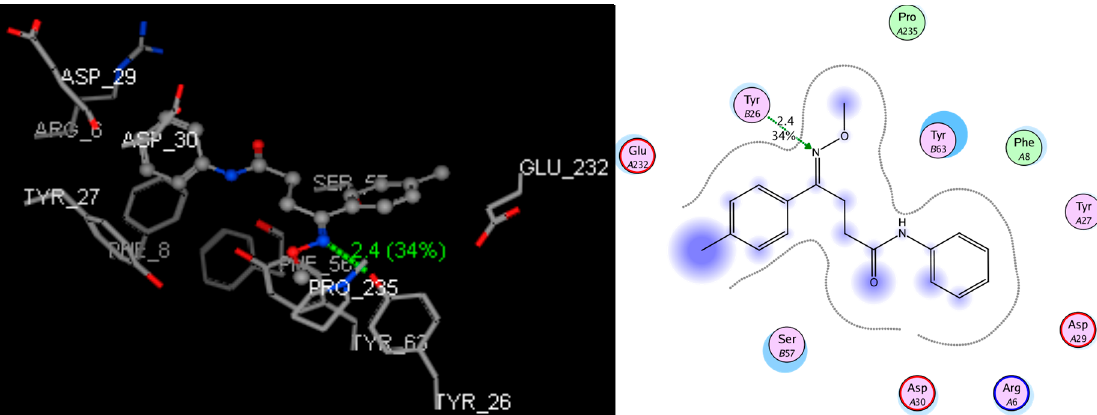
Figure 3. Binding mode of compound 5a-1 with 3OX8. The hydrogen bond formed is colored in green.